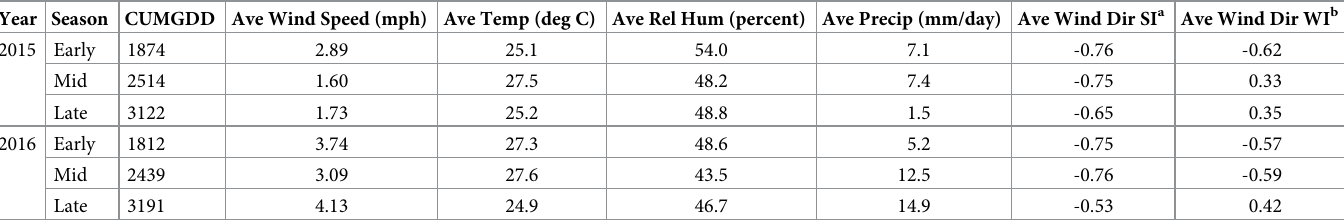
Table 6. Summary of weather variables, early, mid, and late season in 2015 and 2016.